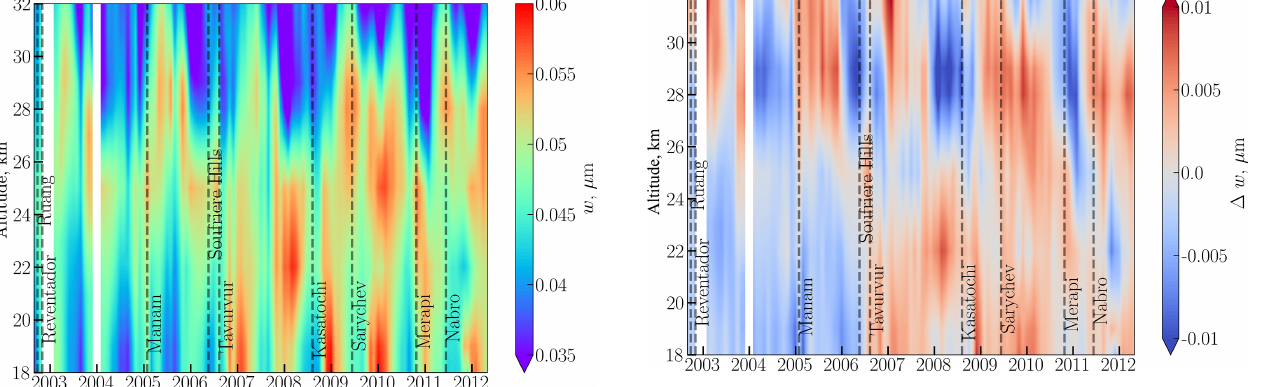
used for each altitude to make the Fig. 13 more descriptive.